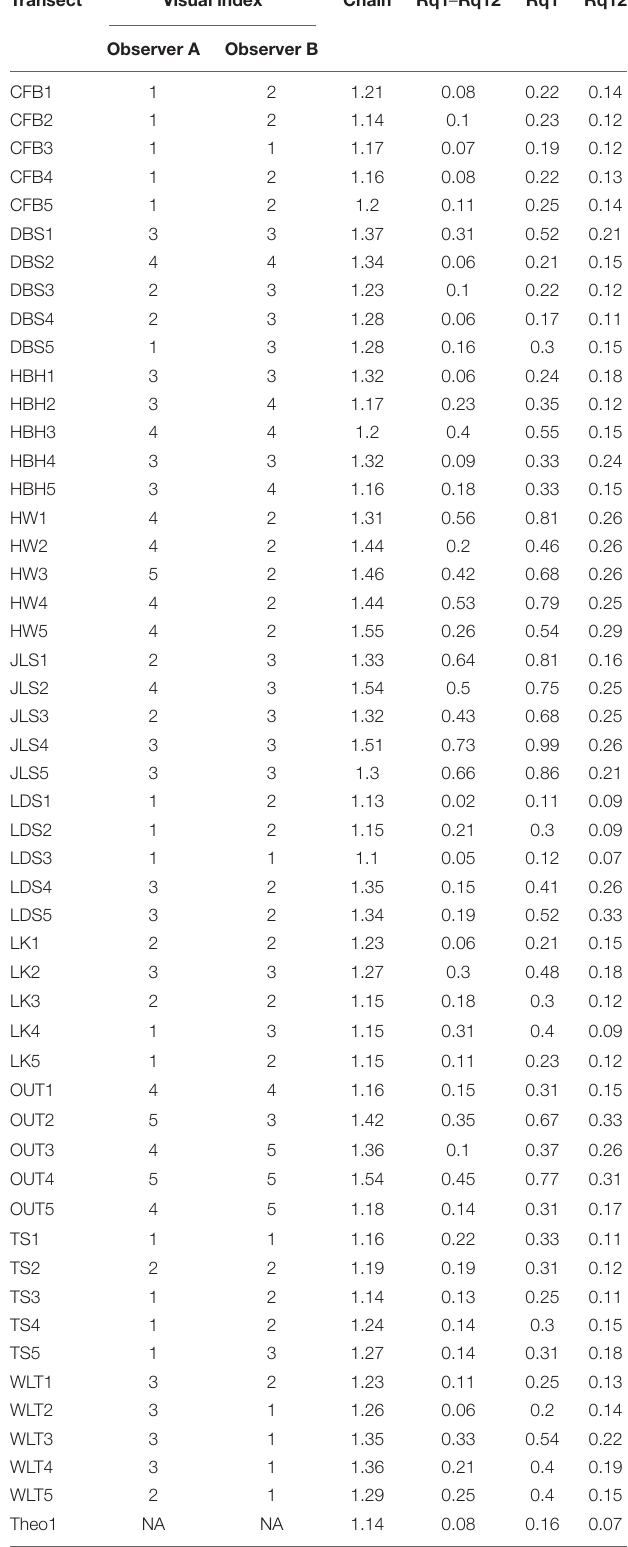
TABLE 2 | Rugosity indices for all theoretical and in situ